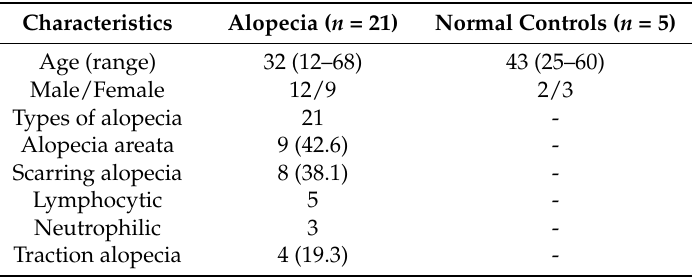
Table 3. Demographic data of the study